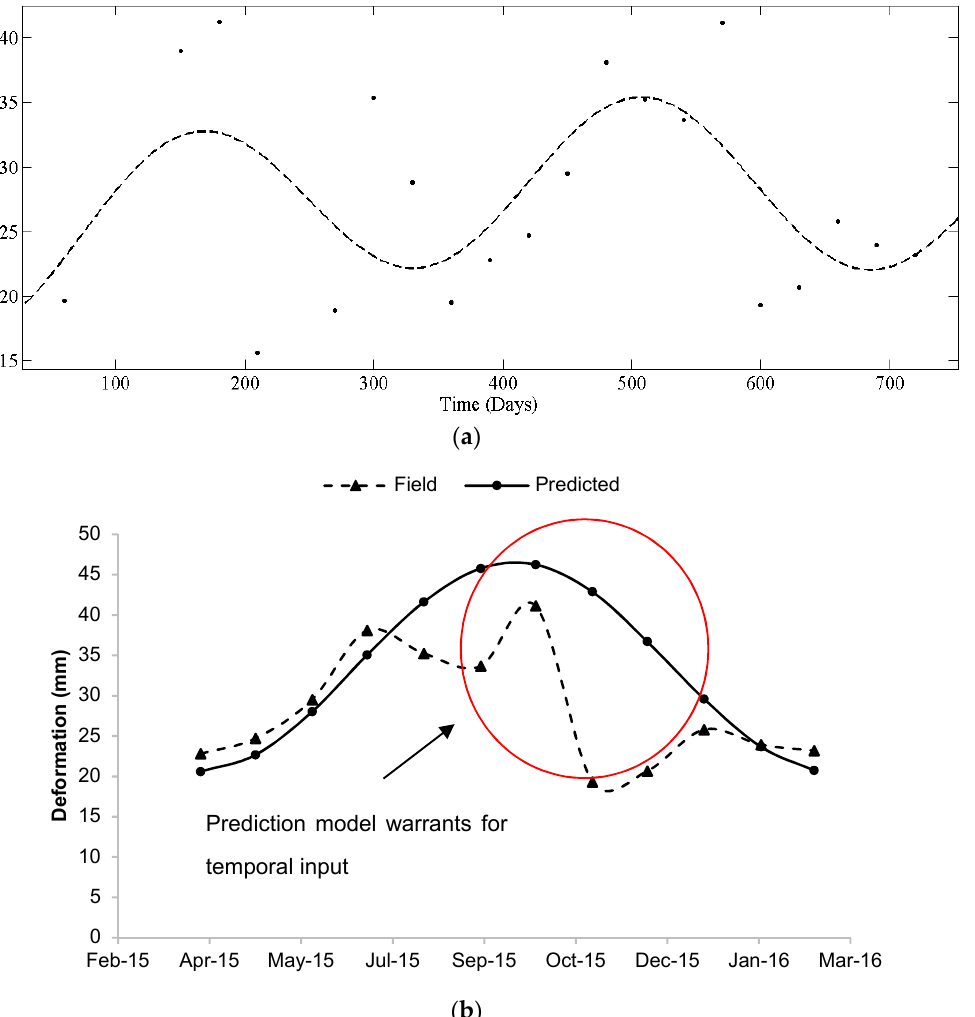
Figure 14. ( a ) Variation of the edge deformation in 2014–16 period ( b ) Predicted and field deformation in 2015–16 period.